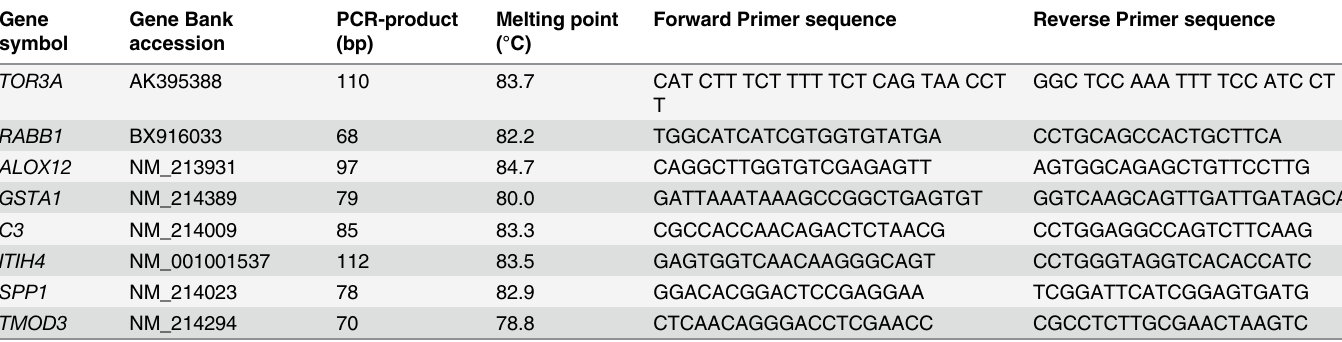
Table 1. Primer sequences used to amplify specific fragments of porcine